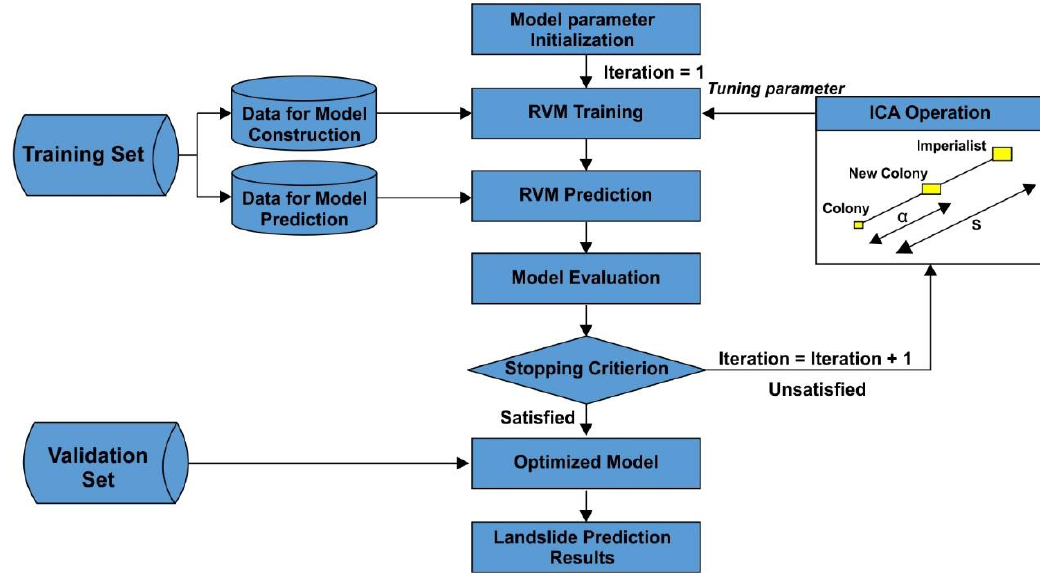
Figure 8. The proposed RVM-ICA used for landslide spatial modeling.